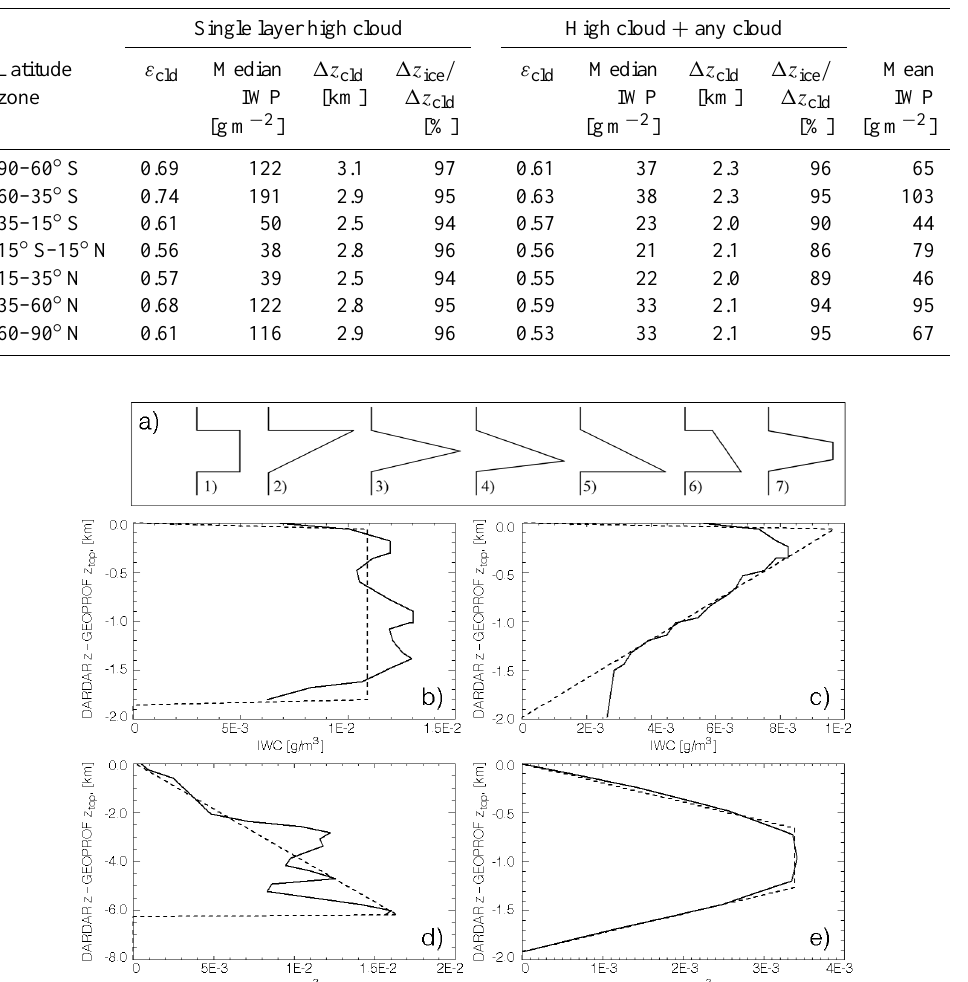
Figure 5. Cloud IWC( z ) examples and their approximation with primitive shapes: (a) initial set of seven profiles; (b) constant-within-layer or rectangular; (c) upper triangle; (d) lower triangle; (e) isosceles trapezoid. Solid lines: DARDAR IWC( z ) profile, dashed lines: best fit profile. Height is shown with respect to GEOPROF z top